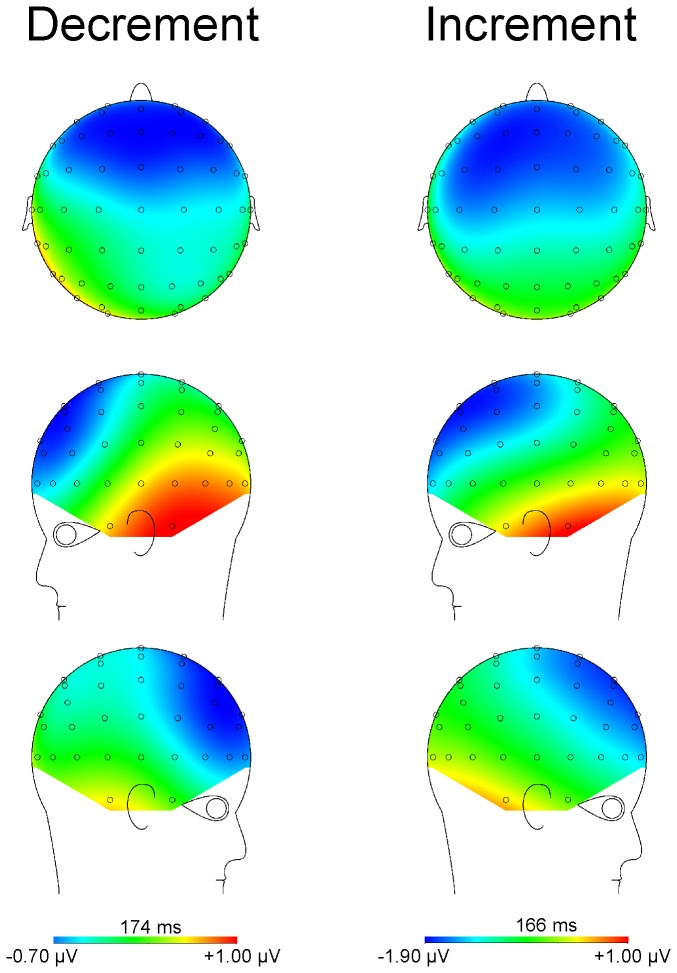
Spline scalp distribution maps of the MMN following presentation of the psychological decrements and increments.Although the MMN elicited by the psychological decrement did not attain significance, its scalp distribution was very similar to that elicited by the psychological increment. The MMNs were maximum over fronto-central areas and inverted in amplitude over inferior-lateral regions.